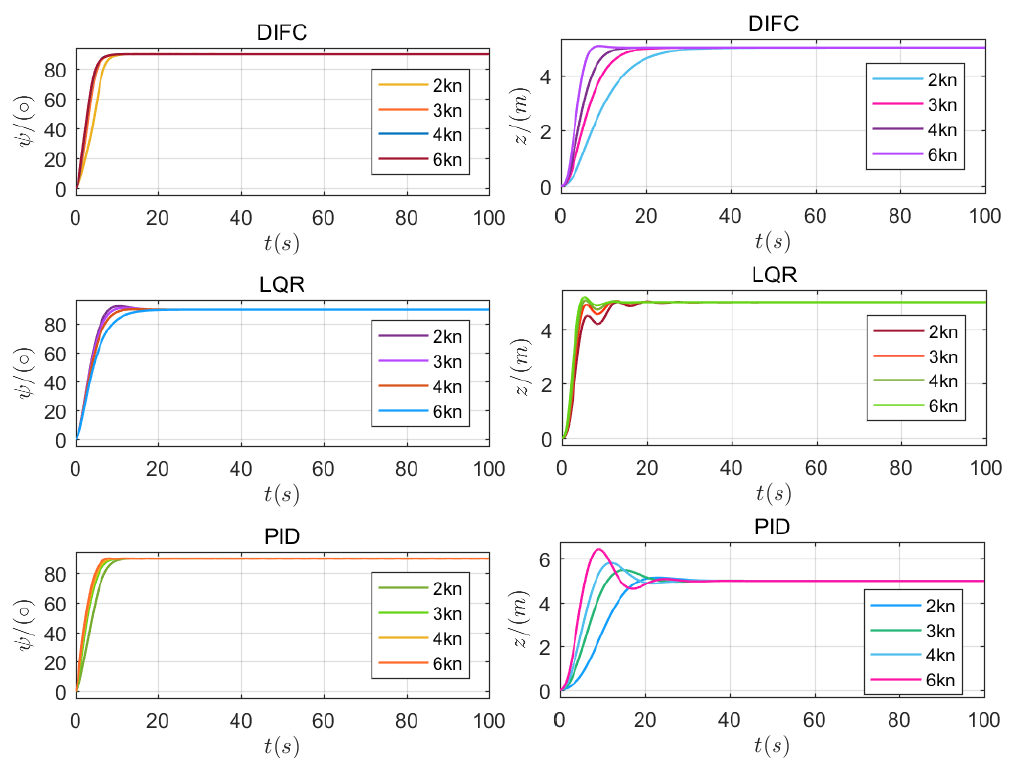
Figure 12. Simulation results under all predefined surge velocity (2 kn, 3 kn, 4 kn, 6 kn). Figures in the first line show the results of DIFC, the second line for LQR, and the third line for PID.